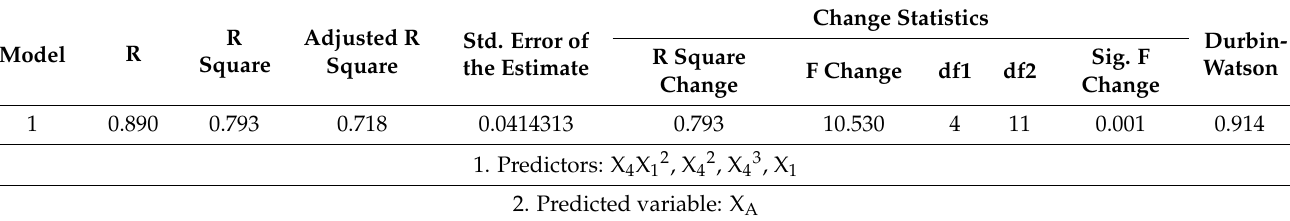
Table 19. 3rd order polynomial model summary with two predictors.